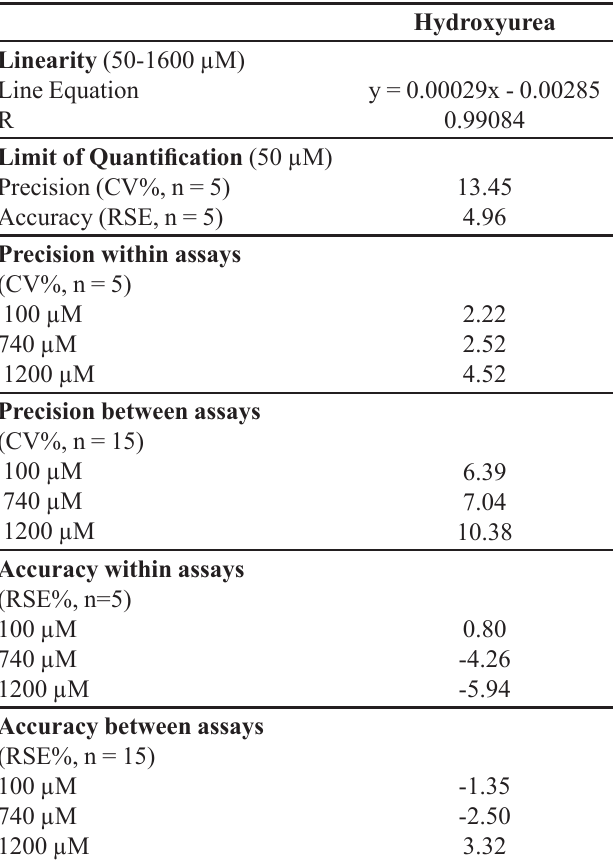
TABLE I - Confidence limits for the method of analysis of hydroxyurea